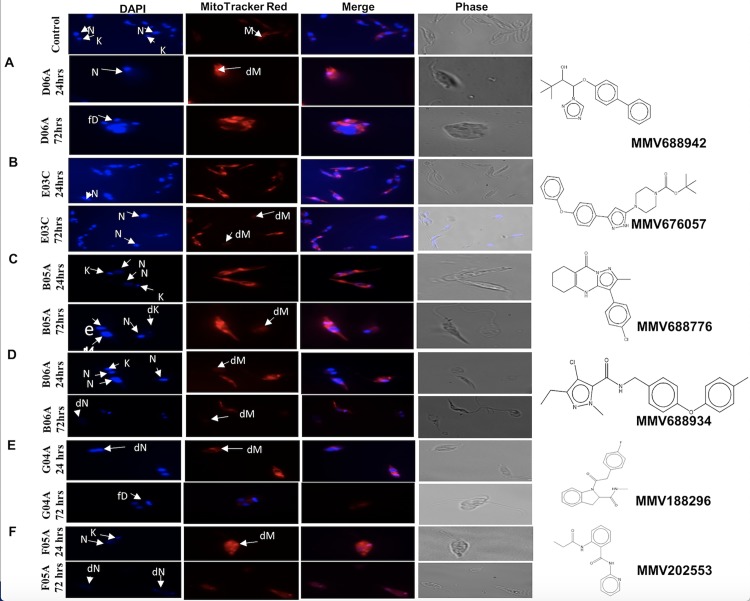
Effect of compounds on the nuclear and kinetoplast DNA, and mitochondria morphology.(A) MMV688942 (D06A) (B) MMV676057 (E03C) (C) MMV688776 (B05A) (D) MMV688934 (B06A) (E) MMV188296 (G04A) (F) MMV202553 (F05A). Promastigotes were cultured in the presence of MMV compounds for 24 hours and 72 hours, stained with DAPI and Mitotracker, and examined by phase contrast microscopy and fluorescence microscopy at x1000. Here, 1μg/ml of the compounds were used. Key: fD = Fragmented DNA; dM = Degenerated Mitochondrion; M = Normal Mitochondrion; N = Nucleus; K = Kinetoplast; eK = enlarged Kinetoplast; dN = Degenerated Nuclei DNA; fD = Fragmented DNA.